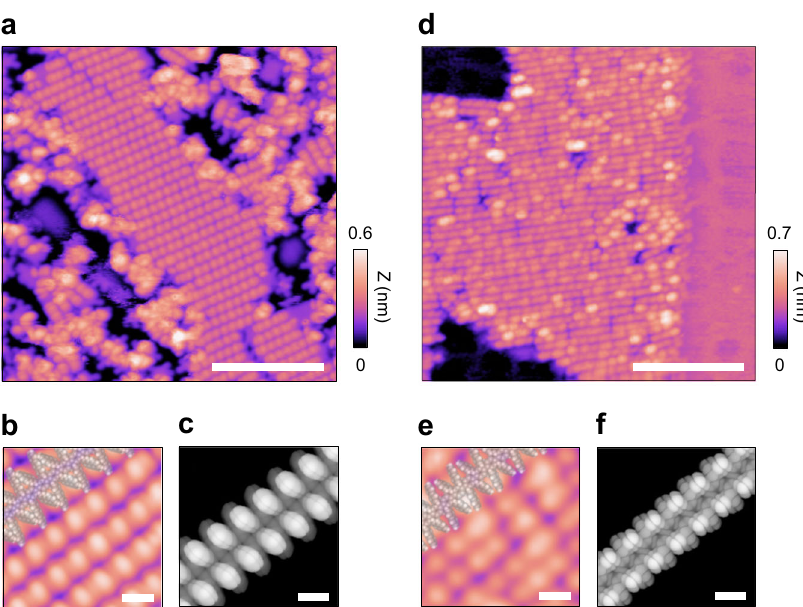
Fig. 2 STM topographies and DFT simulations for 17- and 13-polymers. a Large-scale STM image (scanning paremeters: sample bias V s = 1.1 V, tunneling current I t = 10 pA) of 17-polymers on Au(111) and b small-scale image ( V s = 1.1 V, I t = 10 pA). Structural model of single 17-polymer is superimposed in b . c DFT simulated image (energy window U = 1.1 eV) of the 17-polymer. d Large-scale STM image ( V s = − 1.2 V, I t = 70 pA) of 13-polymers on Au(111) and e small-scale image ( V s = 1.0 V, I t = 10 pA) together with structural model. f DFT simulated image ( U = 1.0 eV) of the 13-polymer. All STM images were taken at 77 K. Scale bar, 10 nm in a , d , 1 nm in b , c , e , f .